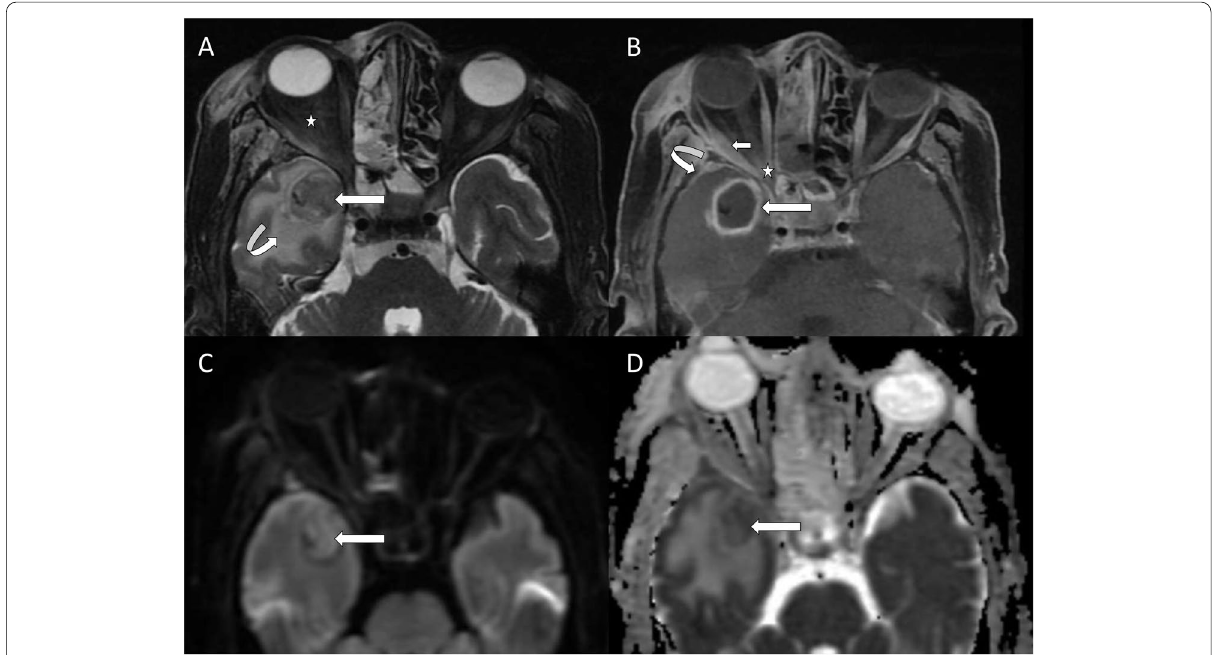
Fig 3 Orbital and cerebral involvement in ROCM. Axial fat-saturated T2-weighted image ( A ) shows a well-defined hypointense lesion (straight long arrow) in the right temporal lobe with surrounding edema (curved arrow). Right intraconal fat (white star) shows stranding with associated